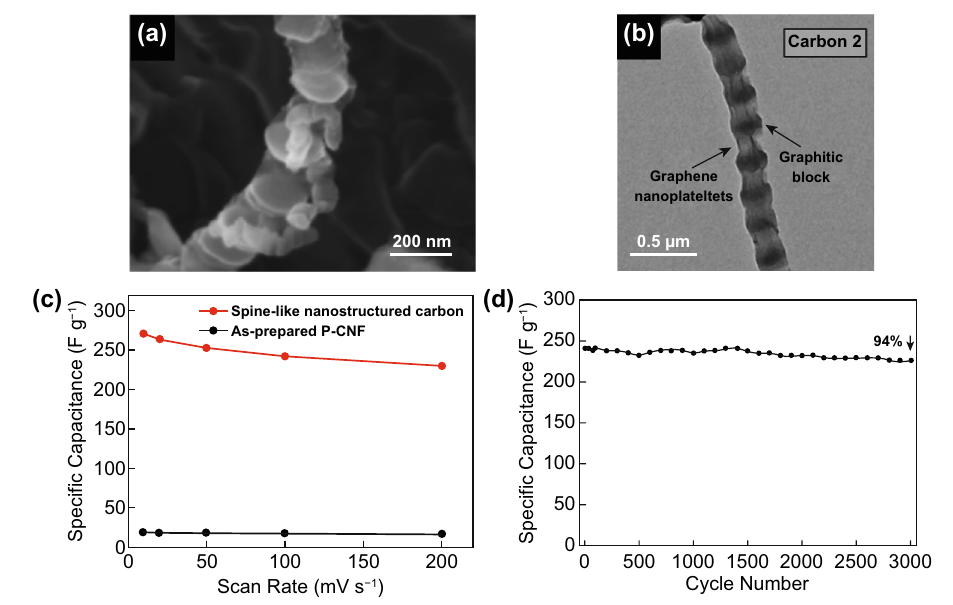
Fig. 12 a‑b SEM and TEM of spine-like nanostructured carbon, c rate capabilities of as-prepared P-CNF and spine-like nanostructured carbon, d cycle stability of the spine-like nanostructured carbon measured at a scan rate of 100 mV s –1 . Reproduced with permission from Ref.